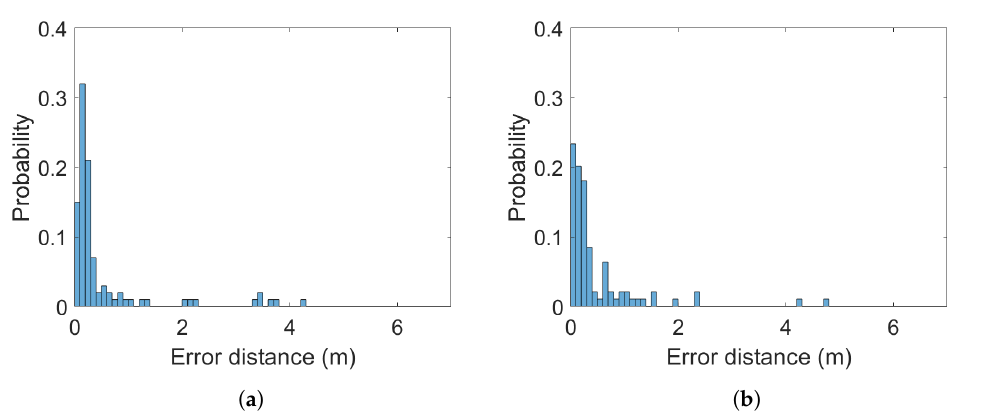
Figure 6. Histograms of error distances across all ground-truth points for ( a ) Pozyx and ( b ) GoT for 1 m altitude (bins: 0.1 m).